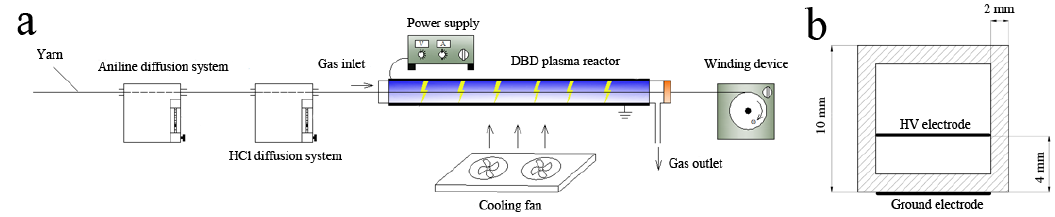
Figure 1. ( a ) Experimental device of vapor phase in situ polymerization of aniline; ( b ) cross section view of electrode configuration.